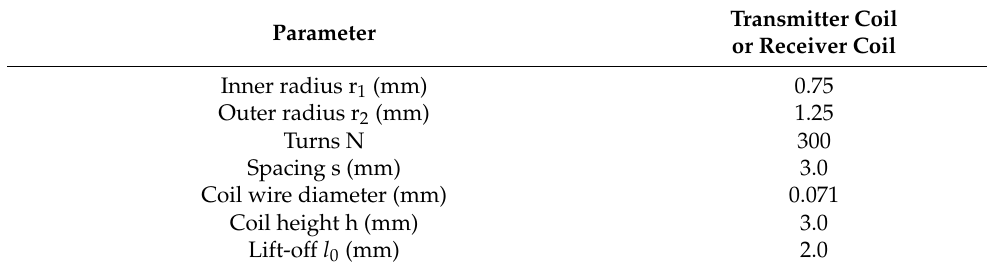
Table 1. Parameters of the T-R eddy current sensor and measurement